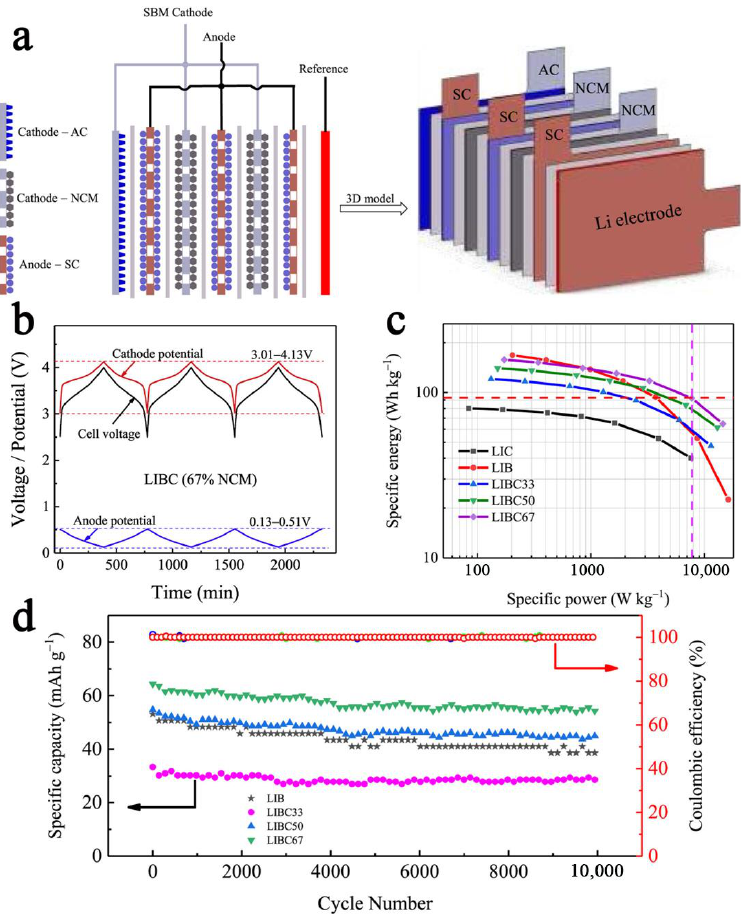
Figure 9. (NCM111+AC)//pre-lithiated SC LIBCs: ( a ) Schematic diagram of a hybrid device with segmented cathode structure; ( b ) cell voltage and electrode potential profiles of LIBC67; ( c ) Ragone plot; ( d ) Cycle performance [61].